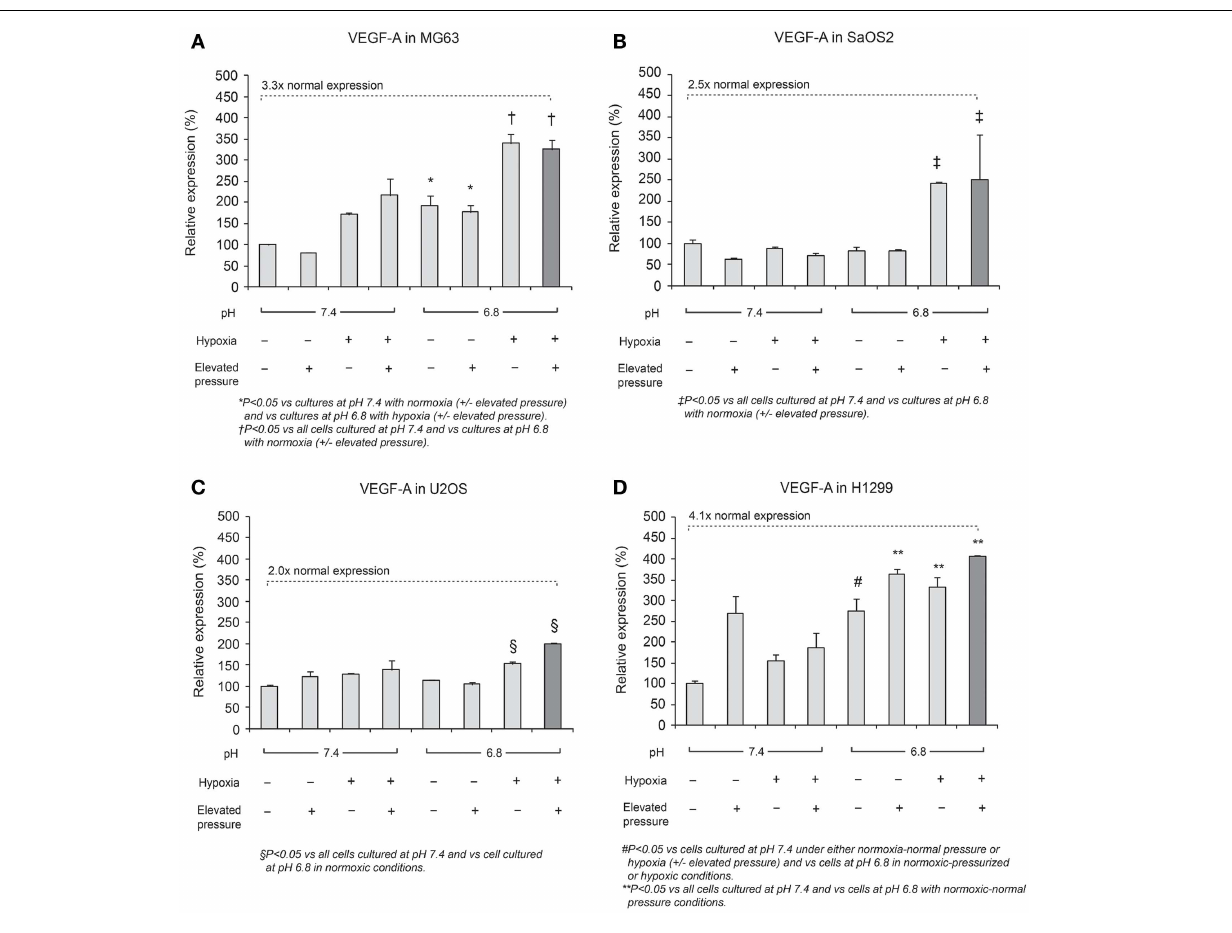
expressed in the combination of low pH, hypoxia, and high pressure.The dotted lines highlight gene expression levels under altered microenvironmental conditions, presented as a multiple of the levels under neutral conditions. VEGF-A expression was 3.3 × higher in MG63 cells, 2.5 × higher in SaOS2, 2.0 × higher in U2OS, and 4.1 × higher in H1299